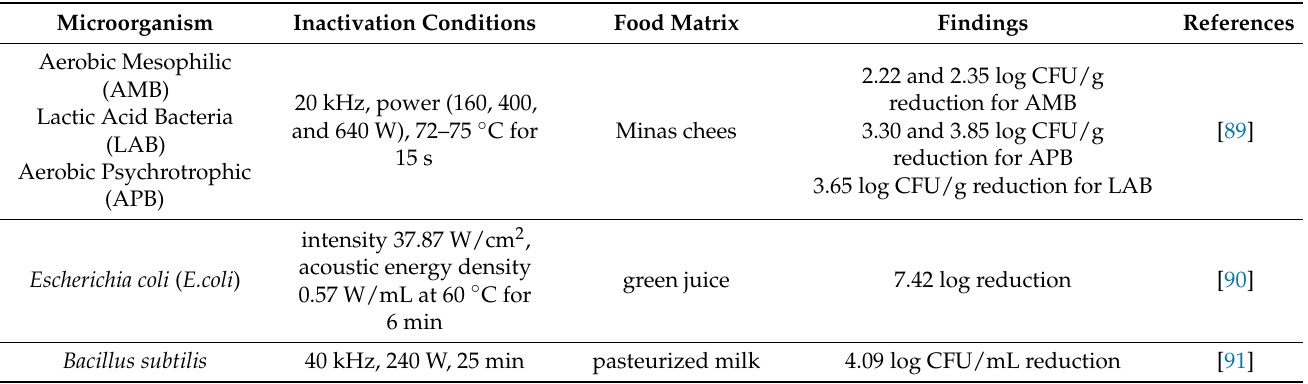
Table 1. Studies of thermosonication (TS) effects on inactivation of microorganisms in some food